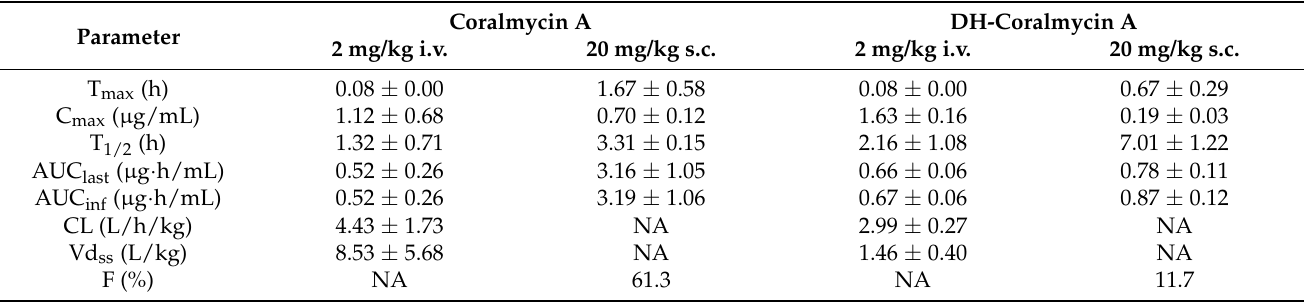
Table 2. Pharmacokinetic parameters of coralmycin A and DH-coralmycin A after i.v. and s.c. administration (mean ± SD, n = 3).